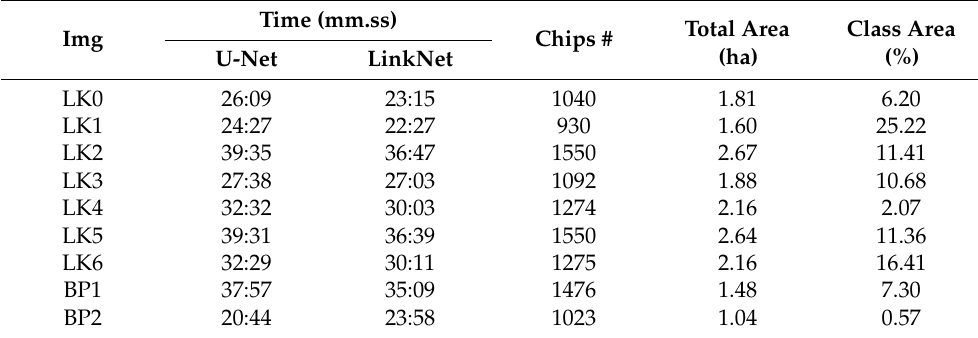
Table 2. The number of chips, total land area in hectares (ha), and proportion of area covered by the purple loosestrife class in each image subset. The number of chips (# chips) in the table refers to the number of tiles each image subset was split into based on 256 × 256 tile size. Time Img